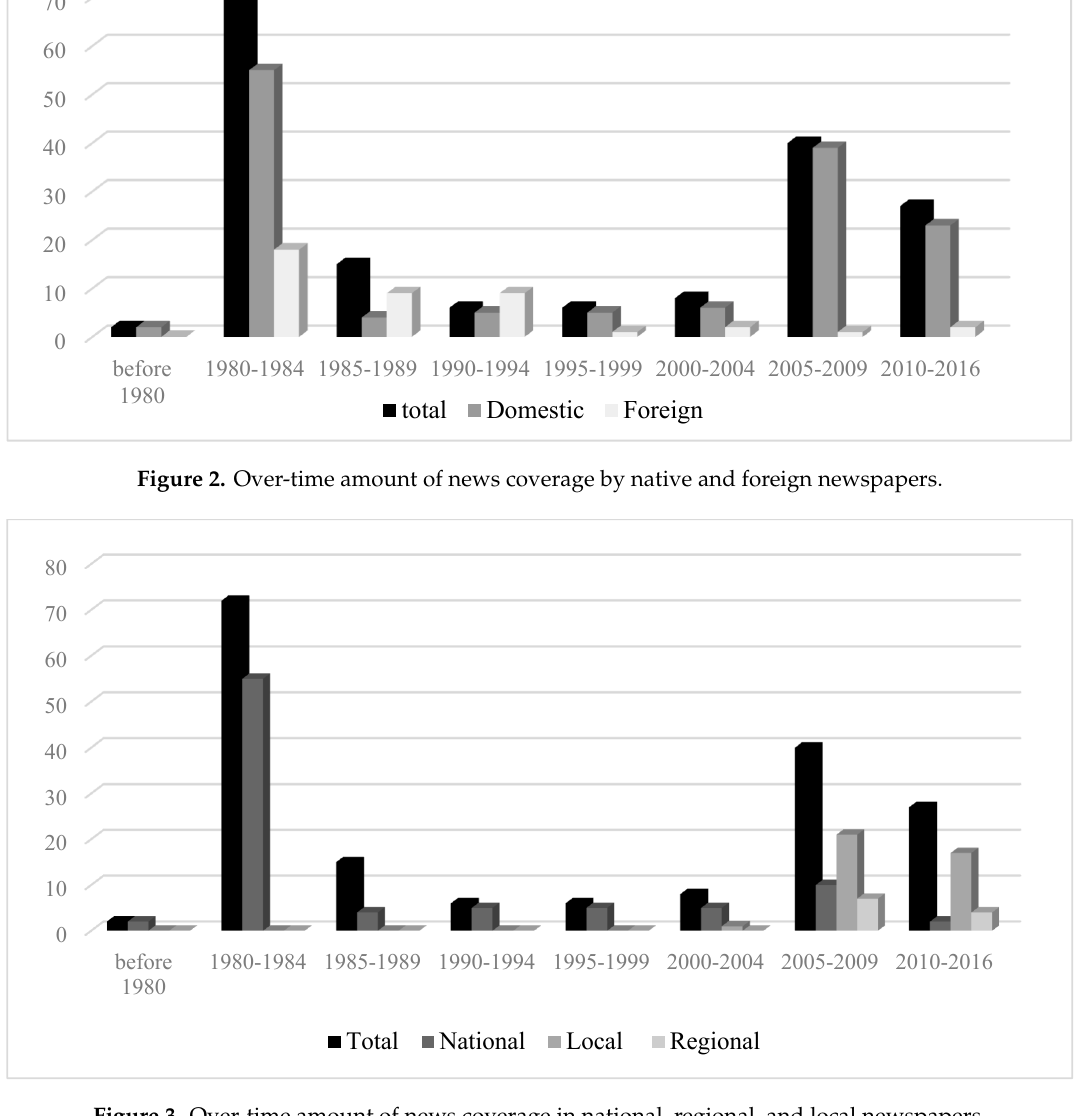
Figure 3. Over-time amount of news coverage in national, regional, and local newspapers.